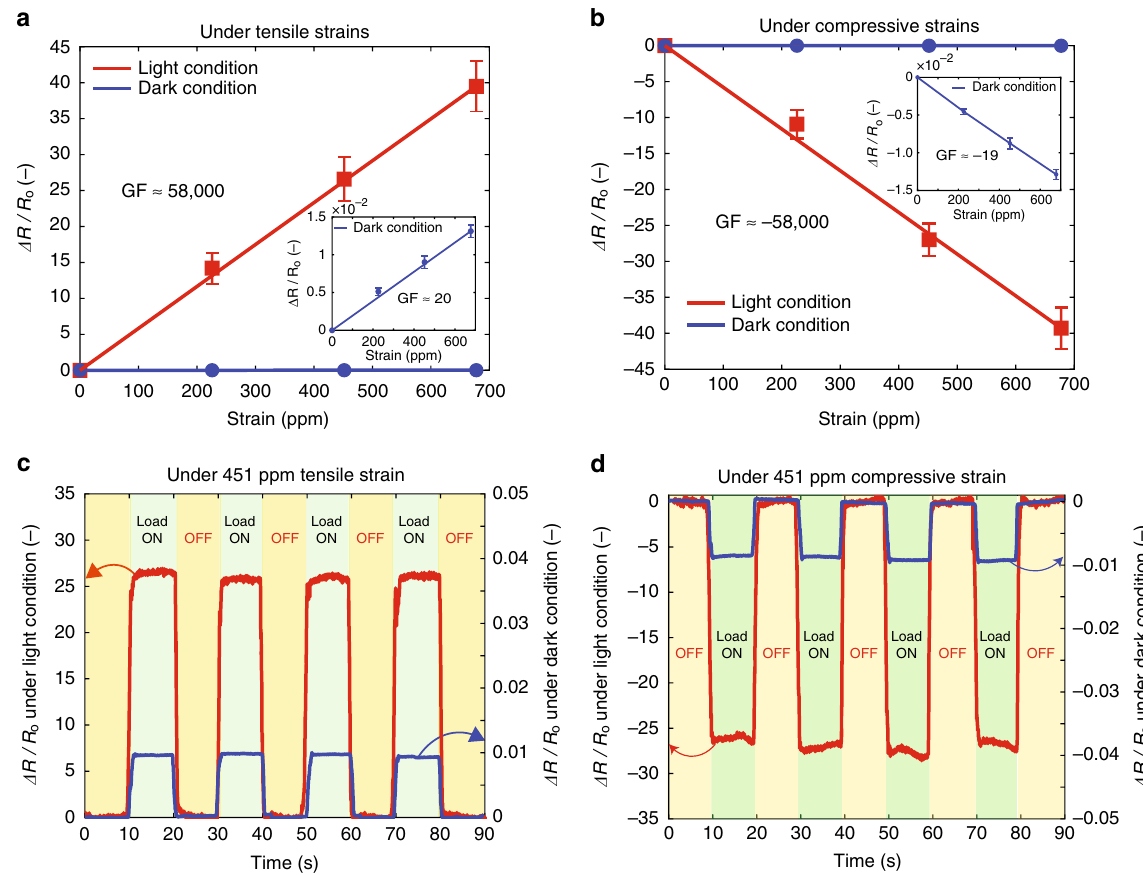
Fig. 2 Enhancement of the piezoresistive effect. An unprecedented high gauge factor (GF) was achieved by simultaneously utilizing the lateral photovoltage and tuning the electric current to modulate the performance of the piezoresistive effect under tensile strain a and compressive strain b . The linearity of the sample applied in this method is excellent. Due to our discovery, a GF as high as 58,000 was achieved under tensile and compressive strain. c Repeatability of the fractional change in resistance under dark and light conditions as 451 ppm tensile strain was periodically turned ON and OFF. d Repeatability of the fractional change in resistance under dark and light conditions as the 451 ppm compressive strain was periodically turned ON and